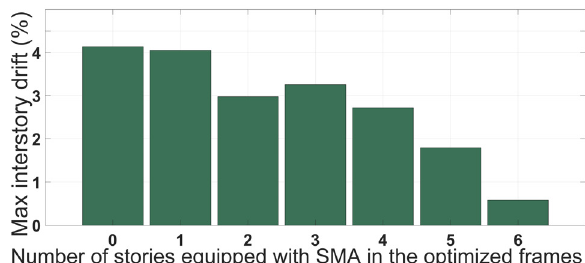
Figure 9: Maximum interstory drift of six-story optimized frame considering the number of floors equipped with SMA braces.